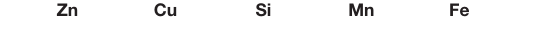
FIGURE 1 | Schematic illustration of the tensile test